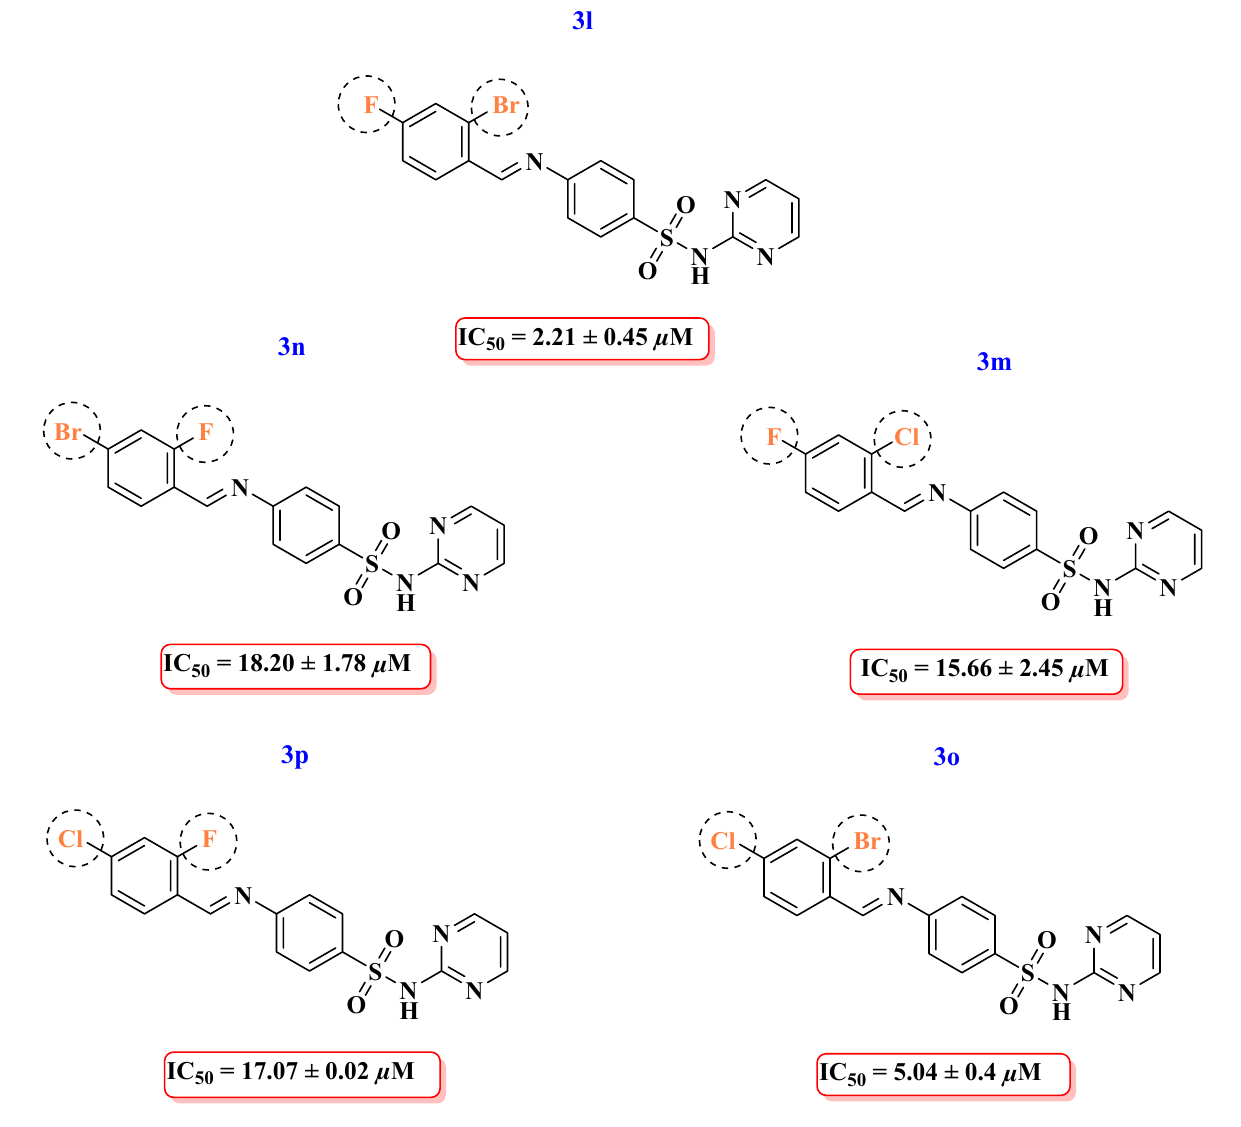
Figure 3. Structure–activity relationship of compounds 3o, 3p, 3l, 3m,